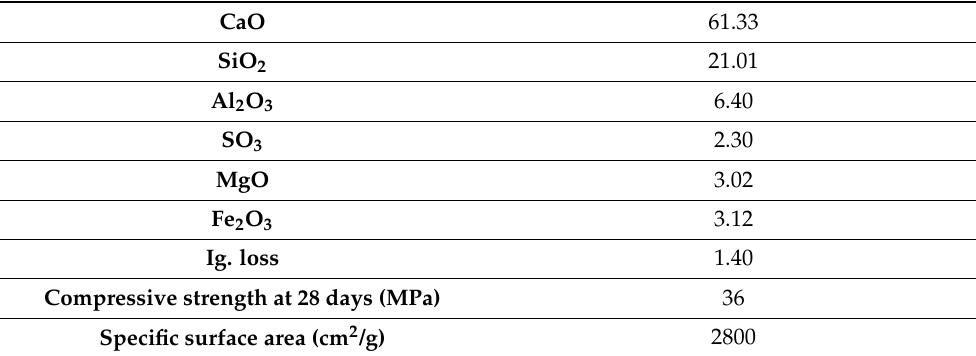
Table 1. Chemical composition and physical characteristics of OPC.